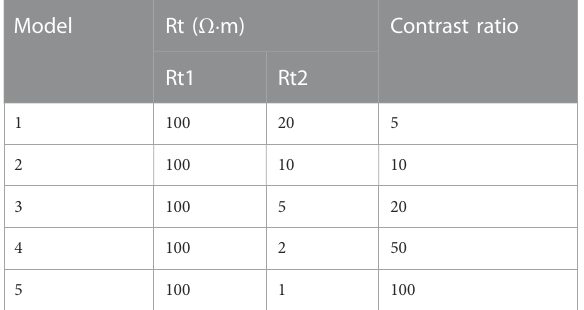
TABLE 1 Stratum model parameters.